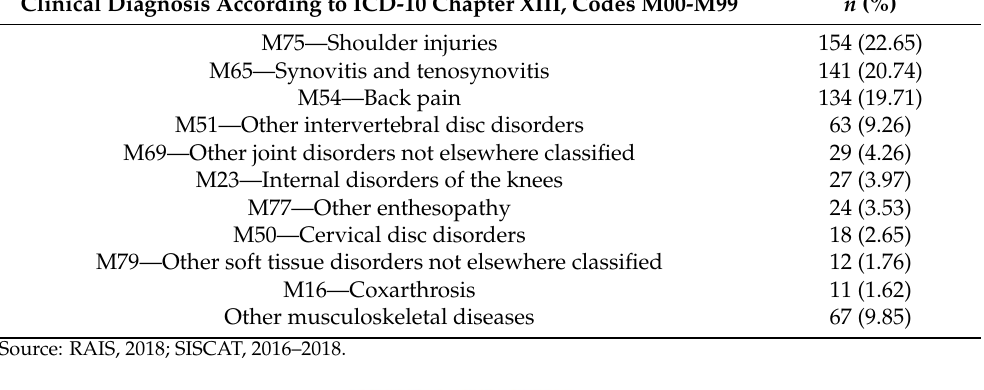
Table 3. Distribution of workers who underwent rehabilitation through Social Security and then returned to the formal employment market, according to their primary clinical diagnoses of disability due to musculoskeletal disorders. Brazil, 2014–2018 ( n = 680). Clinical Diagnosis According to ICD-10 Chapter XIII, Codes M00-M99